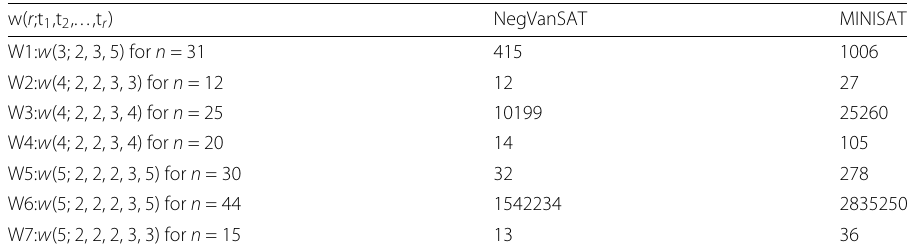
Table 4 Number of